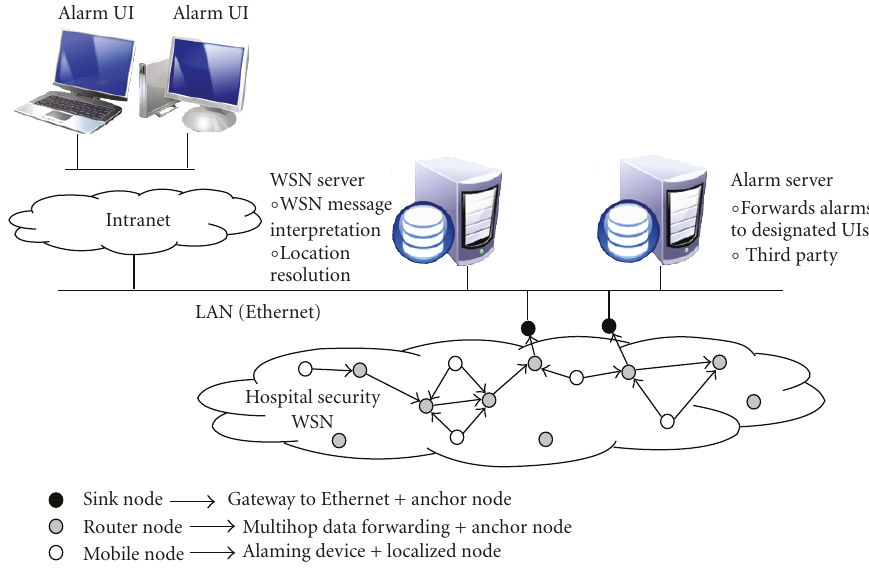
Figure 9: End-to-end hospital security network